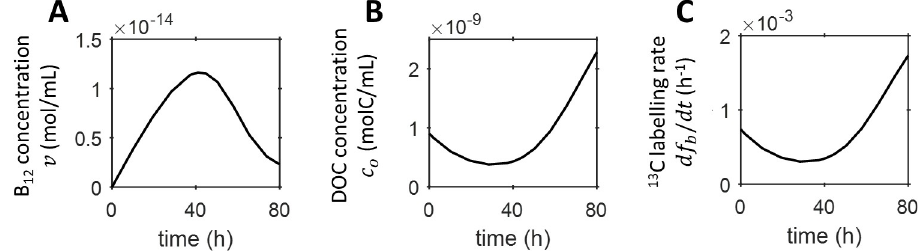
Fig 4. Nutrient kinetics in the co-culture predicted by the model. Concentrations of (A) B 12 and (B) DOC in the co- culture predicted by the nutrient-explicit co-culture model using the parameter optimisation results obtained from fit 1 (Table 1). (C) Isotope labelling rate df b calculated using Eq dt